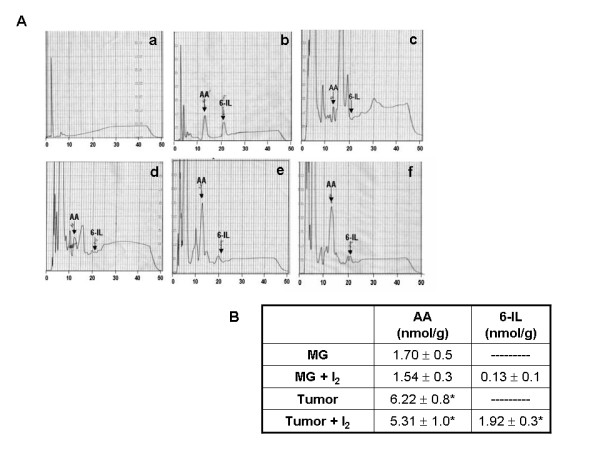
Chromatographic analyzes. Quantification by HPLC of arachidonic acid (AA) content and 6-iodolactone (6-IL) formation in normal (MG) or tumoral (Tumor) mammary glands from rats with or without molecular iodine supplements. A, representative chromatograms; a) base line, b) standards, c) MG control, d) MG +I2, e) tumor, f) tumor + I2. B, quantification; data are expressed as the mean ± SD (n = 10). Differences between experimental groups were analyzed using a one-way ANOVA and the Tukey-HSD Test. *indicates significant difference from the appropriate control (p < 0.05)